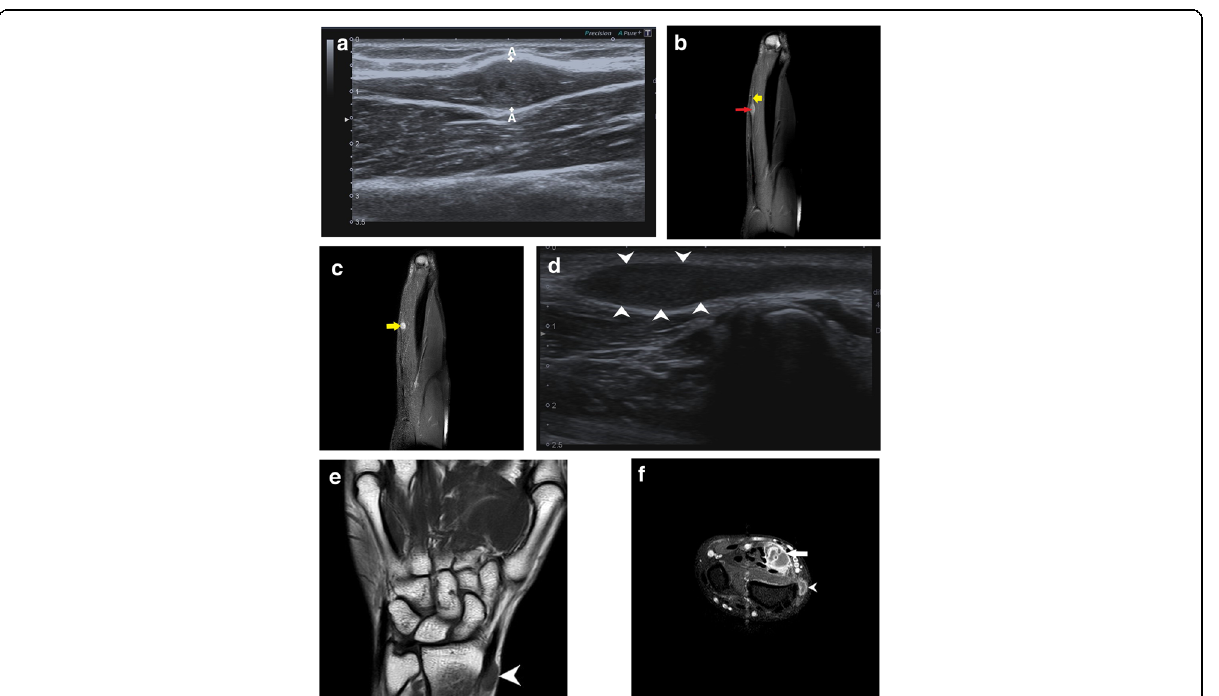
Fig. 15 a Characteristic fusiform swelling in continuity of the ulnar nerve can be seen on this ultrasound image, suggestive of peripheral nerve sheath tumour. b PD FS image shows a fusiform swelling which is hyperintense (red arrow) with internal hypointense areas, suggestive of collagenous stroma. The ulnar nerve (yellow arrow) can be seen forming a tail, entering and exiting from the lesion, which was diagnosed to be a PNST. c Post-contrast T1 FS image shows vivid enhancement in the PNST. d Well-defined fusiform hypoechoic lesion (white arrowheads) is noted in continuity of superficial branch of radial nerve in the region of the anatomical snuffbox, just distal to the radial styloid. e Similar lesions are seen on T1-weighted coronal image. A well-defined, T1 hypointense, fusiform lesion (white arrowhead) in continuity with the superficial branch of radial nerve at the distal end of radius can be seen. f Axial post-contrast fat-saturated T1 image showing well-defined hypointense lesion surrounded by an enhancing capsule (arrowhead) in continuity with superficial branch of radial nerve. Another similar lesion (arrow) showing heterogenous contrast enhancement with hypointense areas within can be seen in continuity with the median nerve. This lesion was T2 and PD hyperintense with cystic degenerative changes on ultrasound and MRI. These MR findings fit the description of